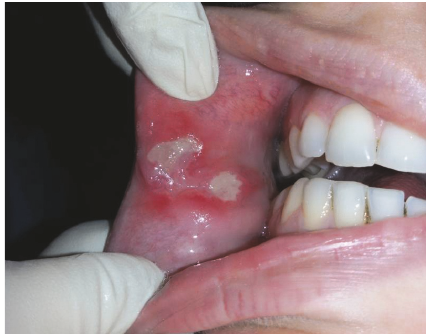
Figure 2: The lesion after light diode applications (wavelength of 630 nm with cycles from 30 seconds, 10 consecutive